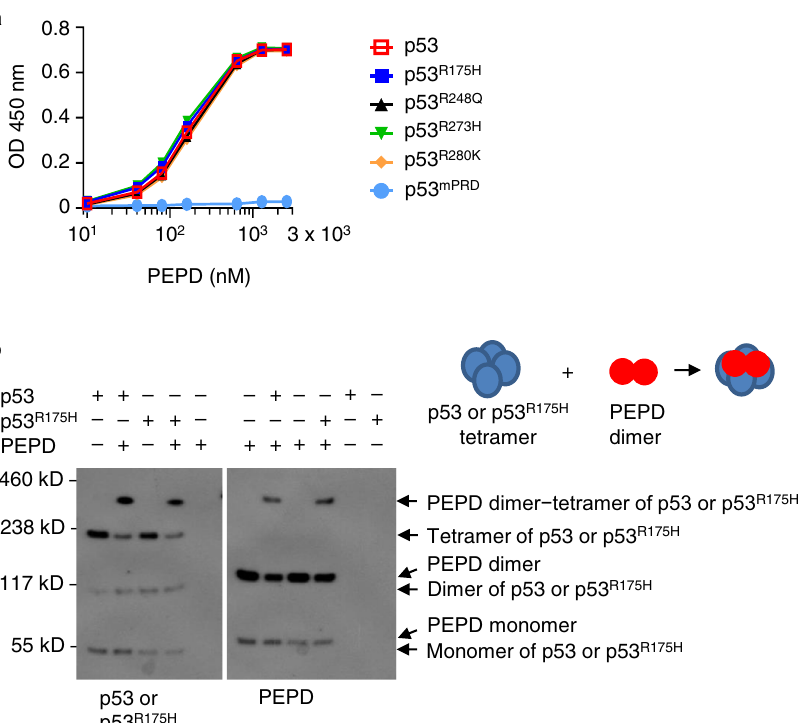
Fig. 1 PEPD binds directly to p53 mutants. a Recombinant human PEPD (10 – 2560 nM) was incubated with recombinant human p53 or p53 mutants (250 nM) overnight at 4 °C. Their binding was measured by ELISA. Each value is mean ± SD ( n = 3). b Recombinant human PEPD (801 nM) and p53 (114 nM) or p53 R175H (114 nM) were incubated alone or with each other for 15 min at room temperature, then incubated with BS3 (a cross-linker) for 30 min at room temperature, and analyzed by WB for PEPD, p53 and p53 R175H . p53 was included in each experiment for